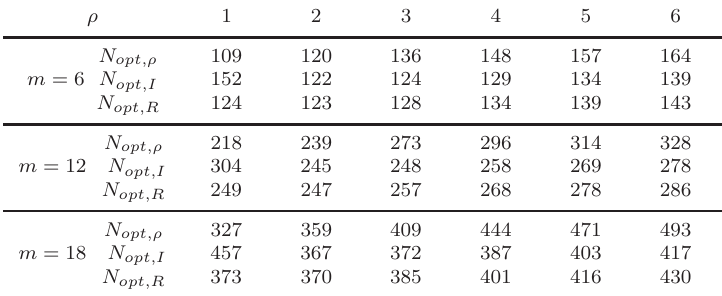
Table 2. Optimal parameters N opt,ρ , N opt,I and N opt,R corresponding to ρ and r 0 .